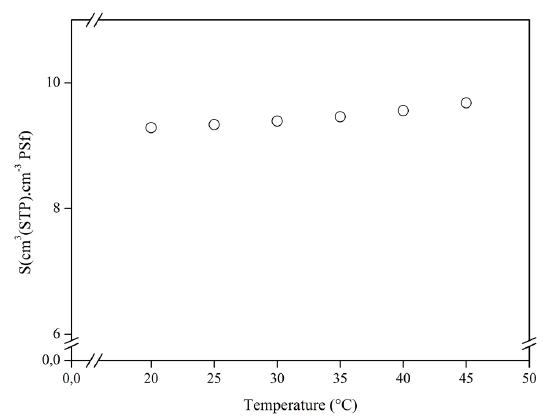
diffusivity coefficients in PSf membrane as a Figure 9 - CO 2 temperature function at 2 bar.